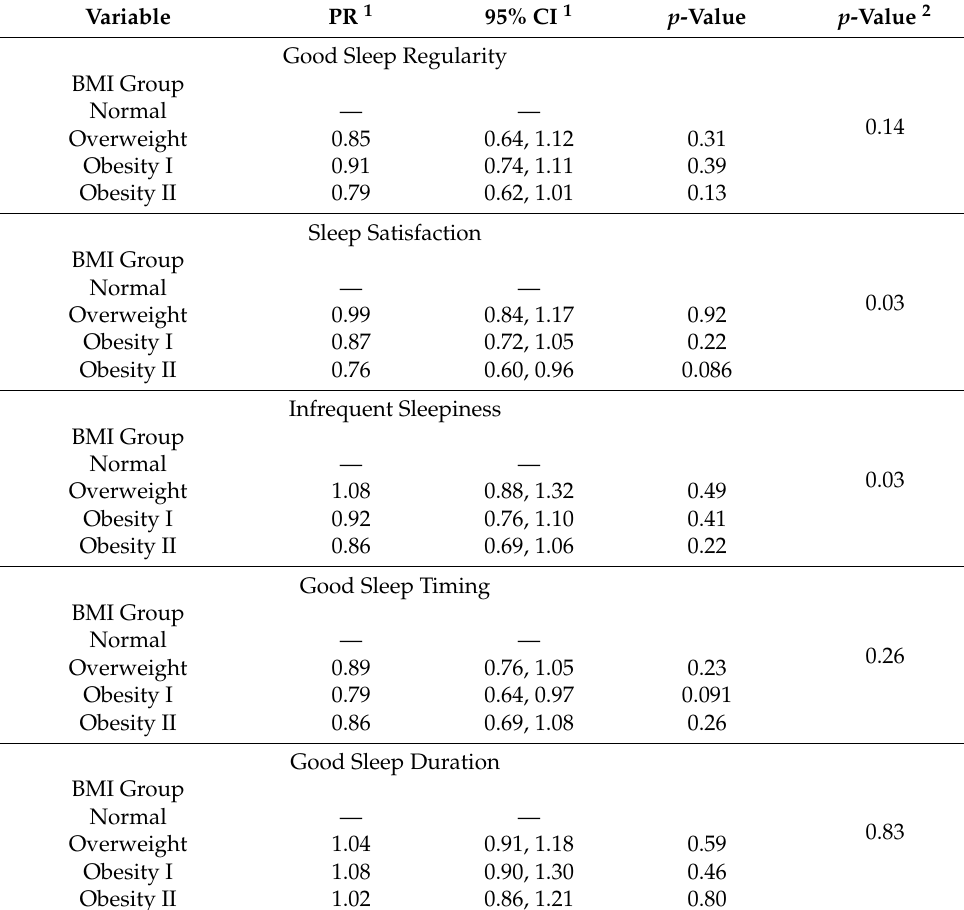
Table 5. Prevalence ratios for good sleep health indicators among adults who attempted weight loss by BMI group.